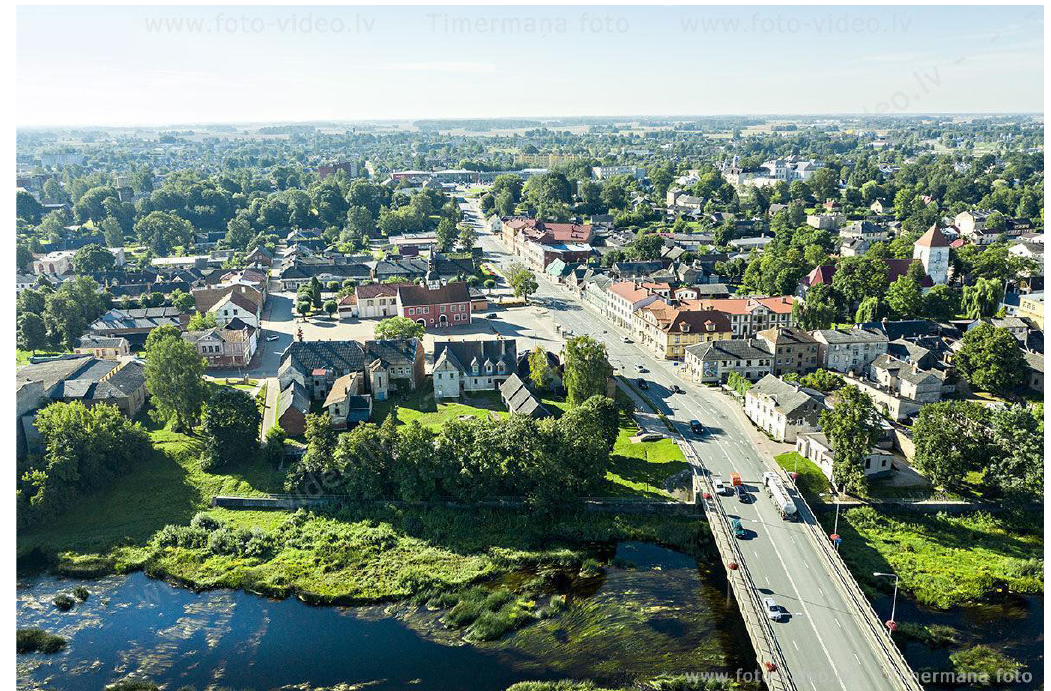
Figure 5. Aerial view of Bauska: In the middle are the former town hall and town hall square, with Kalna Street to the right. Source: Timermanis (n.d.).